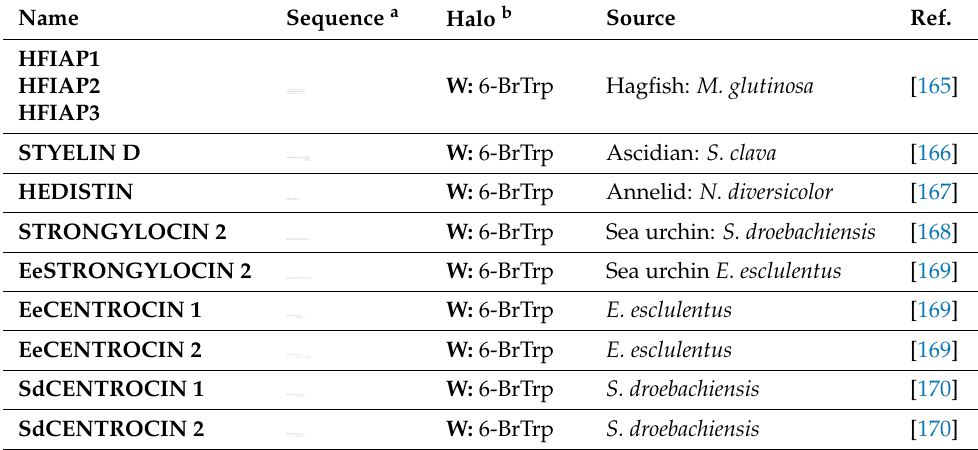
Table 3. Gene-encoded, ribosomally synthesized peptides cited in the review (adapted from Ref.